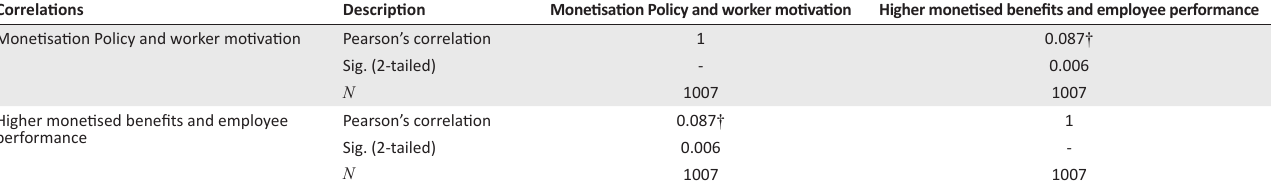
TABLE 3: Pearson’s product–moment correlation test of Hypothesis 2. Correlations Description